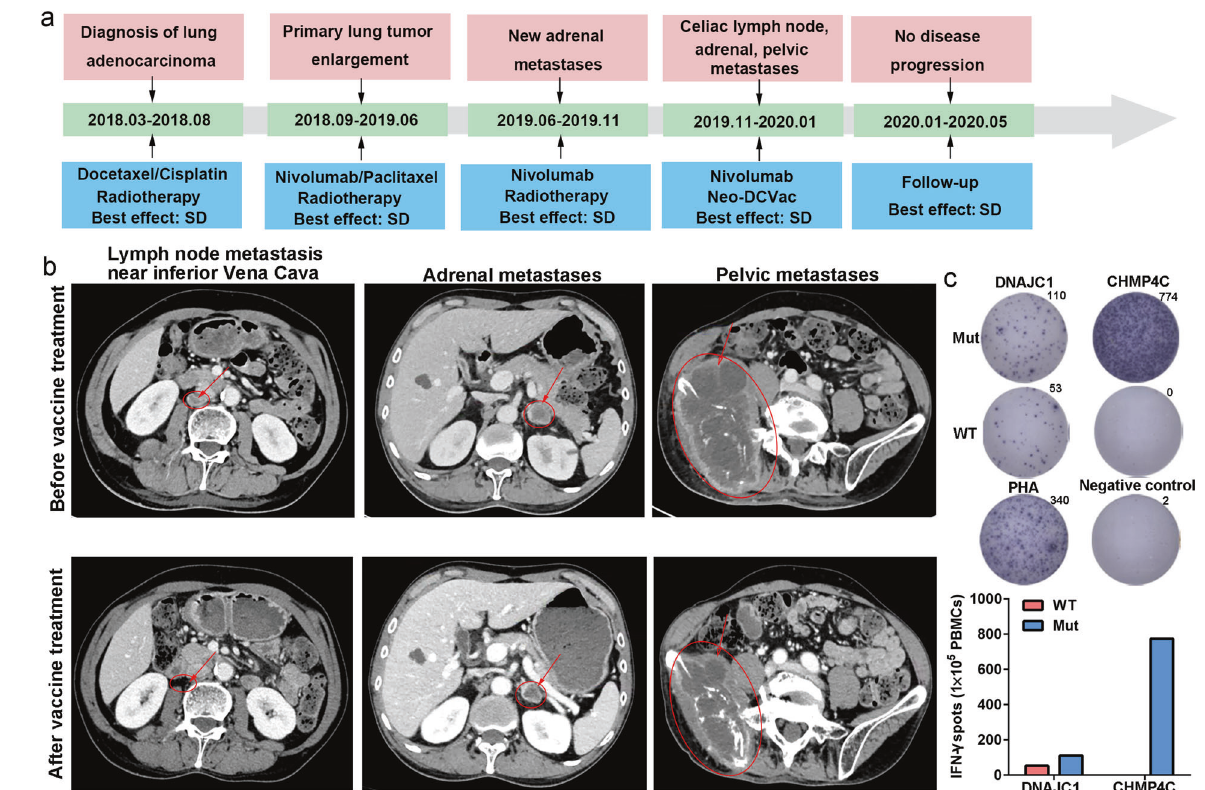
Fig. 5 Clinical and immune responses to personalized Neo-DCVac in patient 17. a Clinical course of the disease and previous treatments of patient 17. The patient failed three lines of chemotherapy, radiotherapy and PD-1 inhibitor, and his tumor target lesions were reduced by 29% following Neo-DCVac administration. b Computed tomography (CT) scans were performed before and after personalized Neo-DCVac immunotherapy, and representative images are shown. c Autologous PBMCs were stimulated with 15 candidate mutant peptides for 10 days, after which IFN- γ ELISpot assays were performed to assess the T-cell-speci fi c antigen